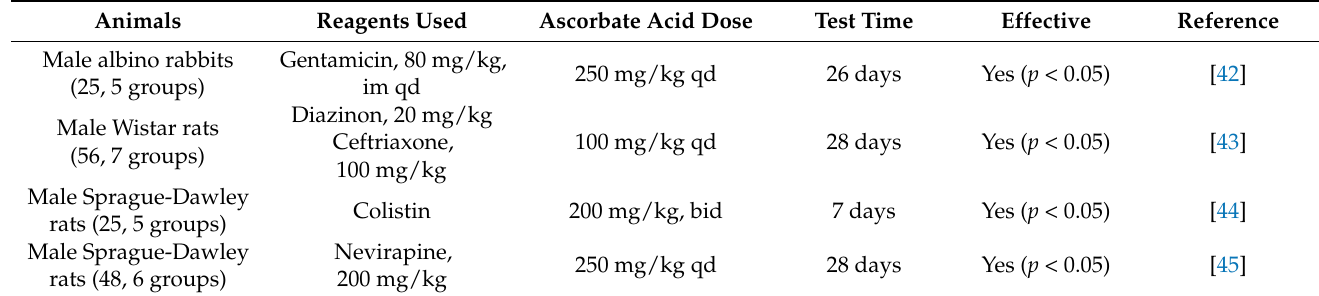
Table 1. Vitamin C’s protection function in the kidney